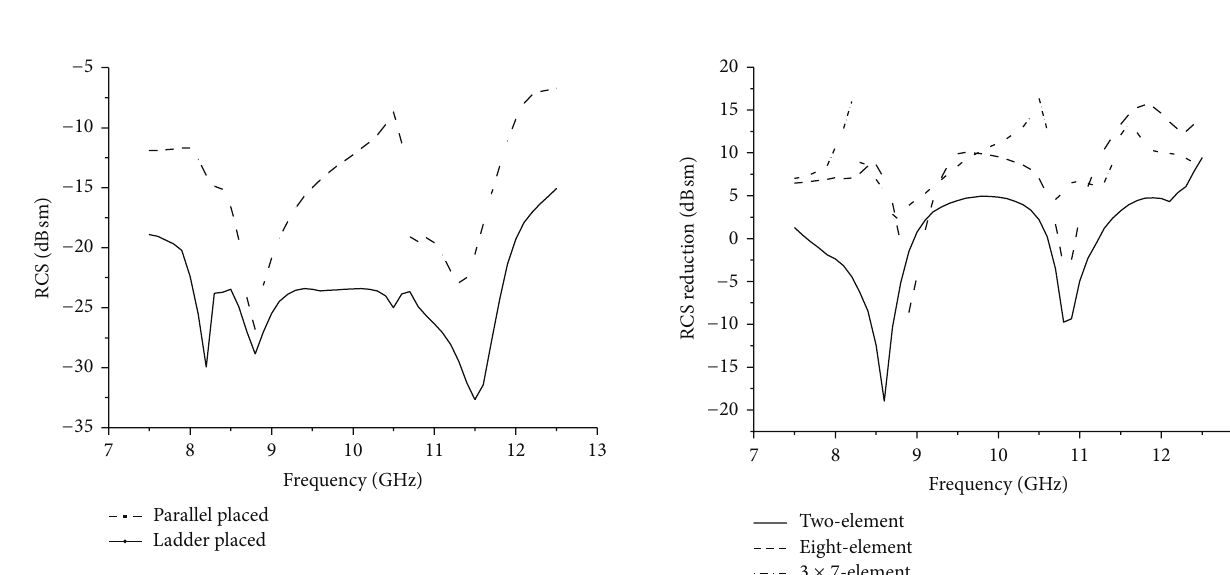
Figure 12: RCS reduction of different antenna